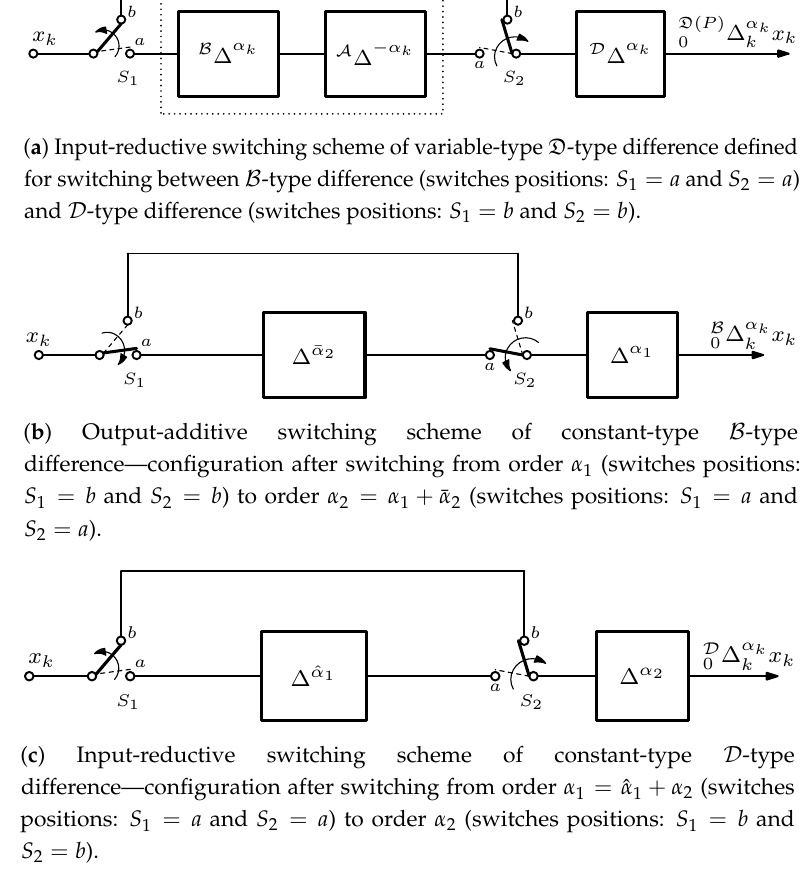
Figure 1. Simple variable and constant-type switching